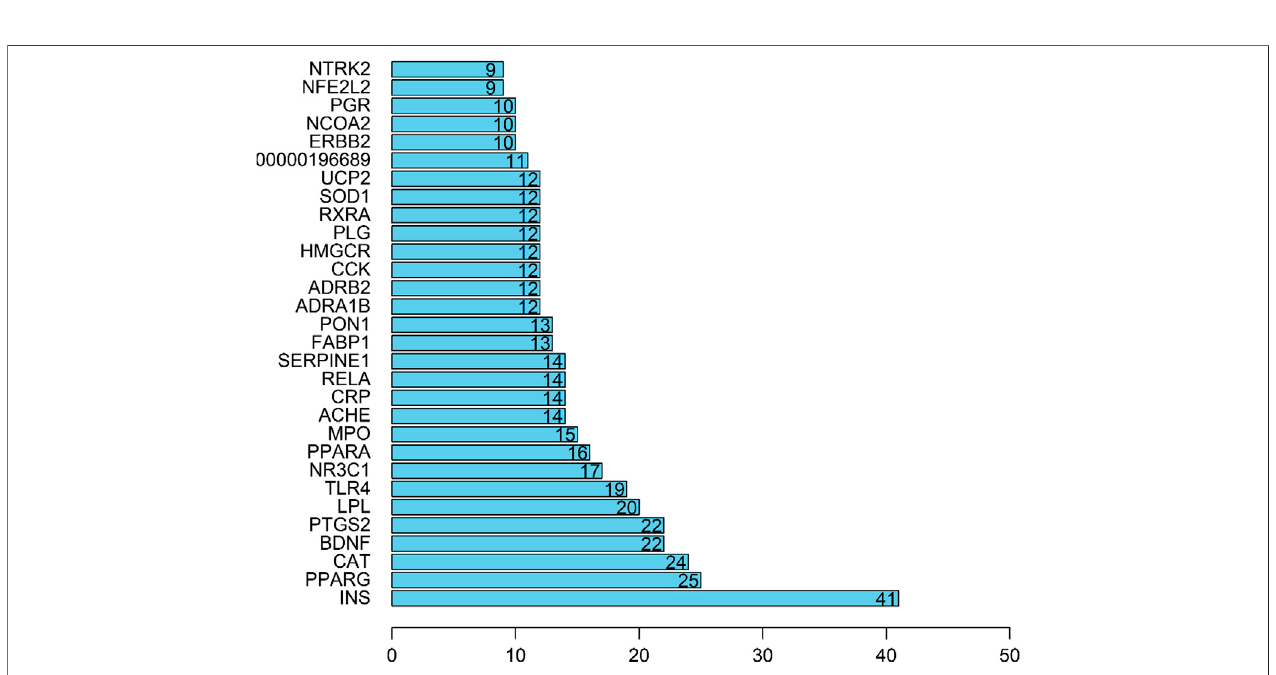
FIGURE 4 | Core target of cinnamon for the treatment of breast cancer.